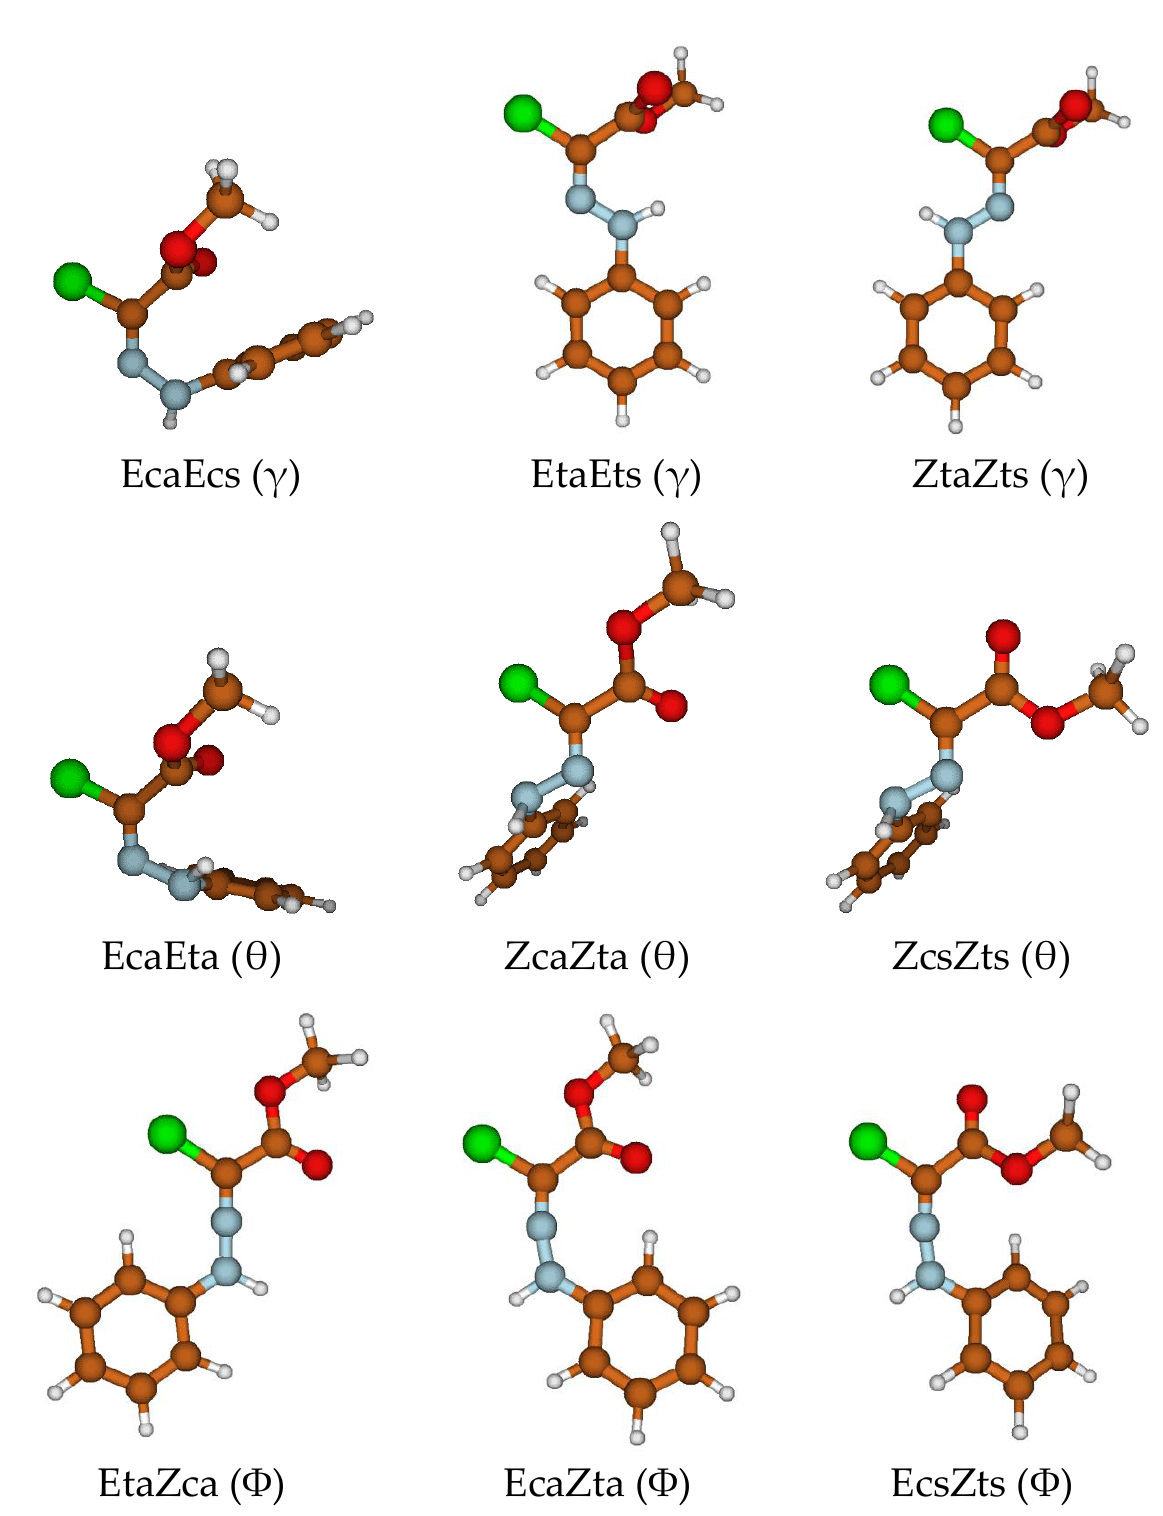
Figure 14. Activation barriers, Δ G ‡ , at 298 K of the isomerization processes of 1 calculated at ω B97M-D4/cc-pVTZ level of theory. The barriers are grouped as to the isomerization type. Selected TS structures are shown in Figure 15 and selected molecular geometric pa- rameters of the TS structures of 1 are collected in Table 9.